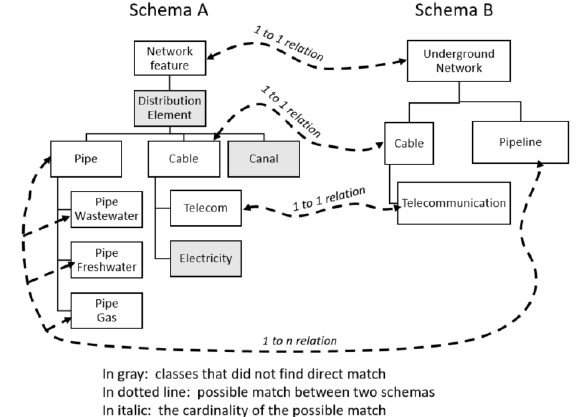
Figure 1 – A simple example of possible matches between two